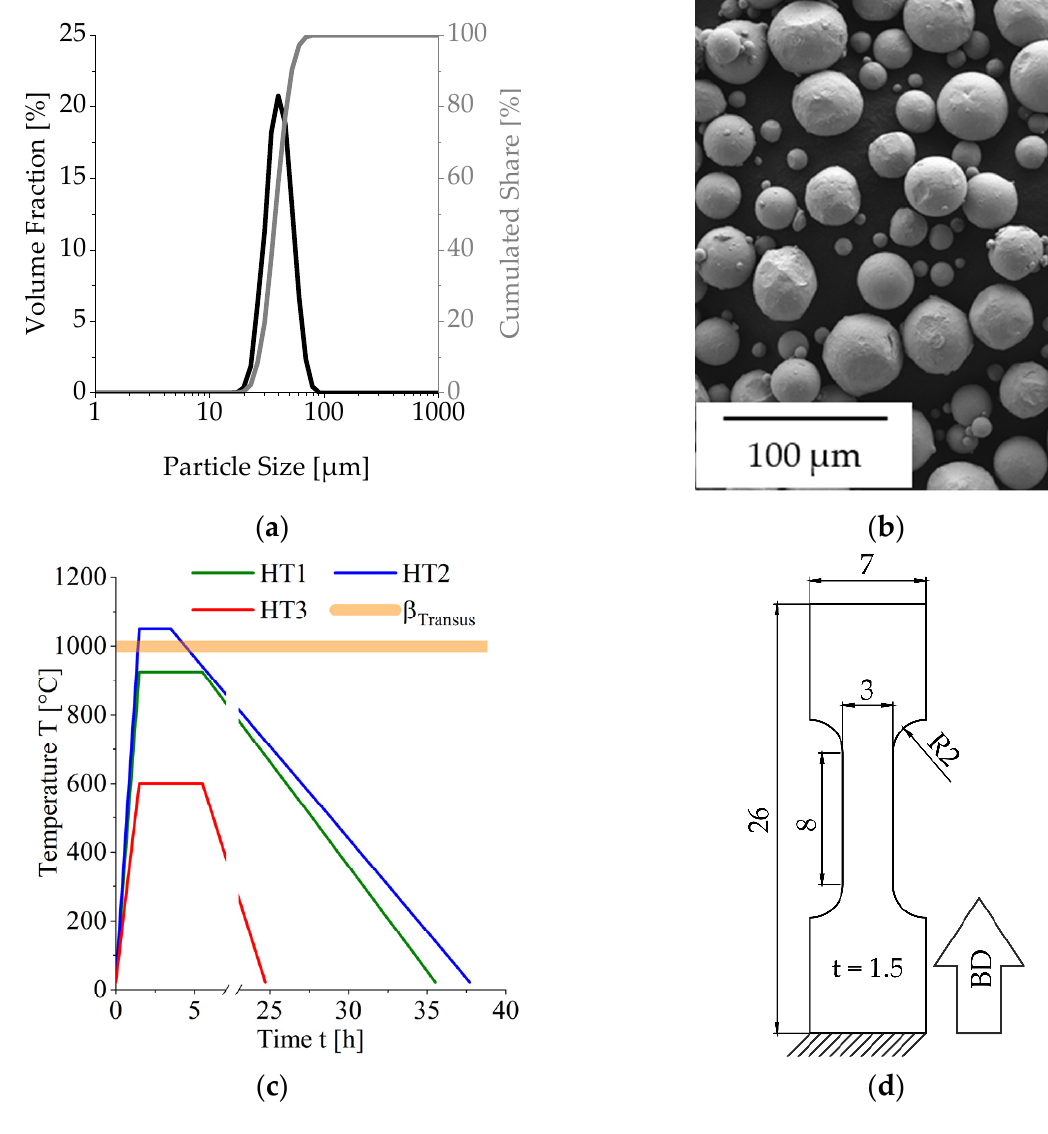
Figure 1. ( a ) Particle size distribution of Ti-6Al-7Nb; ( b ) powder morphology (SEM image); ( c ) schematic overview of the different heat treatments conducted—recrystallization annealing (HT1), β annealing (HT2), and stress relieving (HT3), as well as the β transus temperature for the alloy; ( d ) geometry and building direction (BD) of tensile and fatigue specimens.